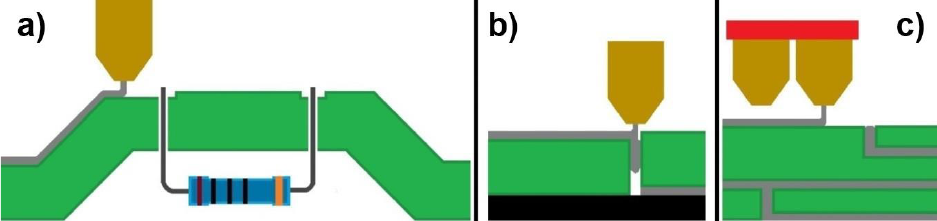
Figure 9. Schematic illustration of FDMm process: ( a ) on curved, 3D shaped substrate; ( b ) for double layer circuit board; ( c ) for multilayer circuit board.